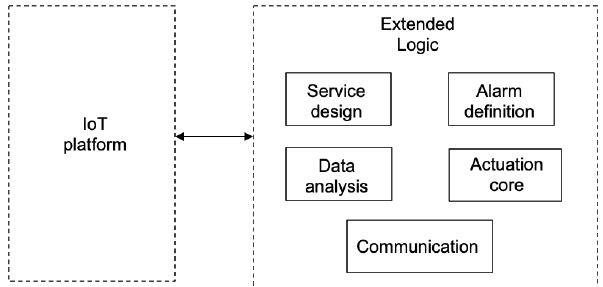
Figure 7. Proposed solution and enhancement.